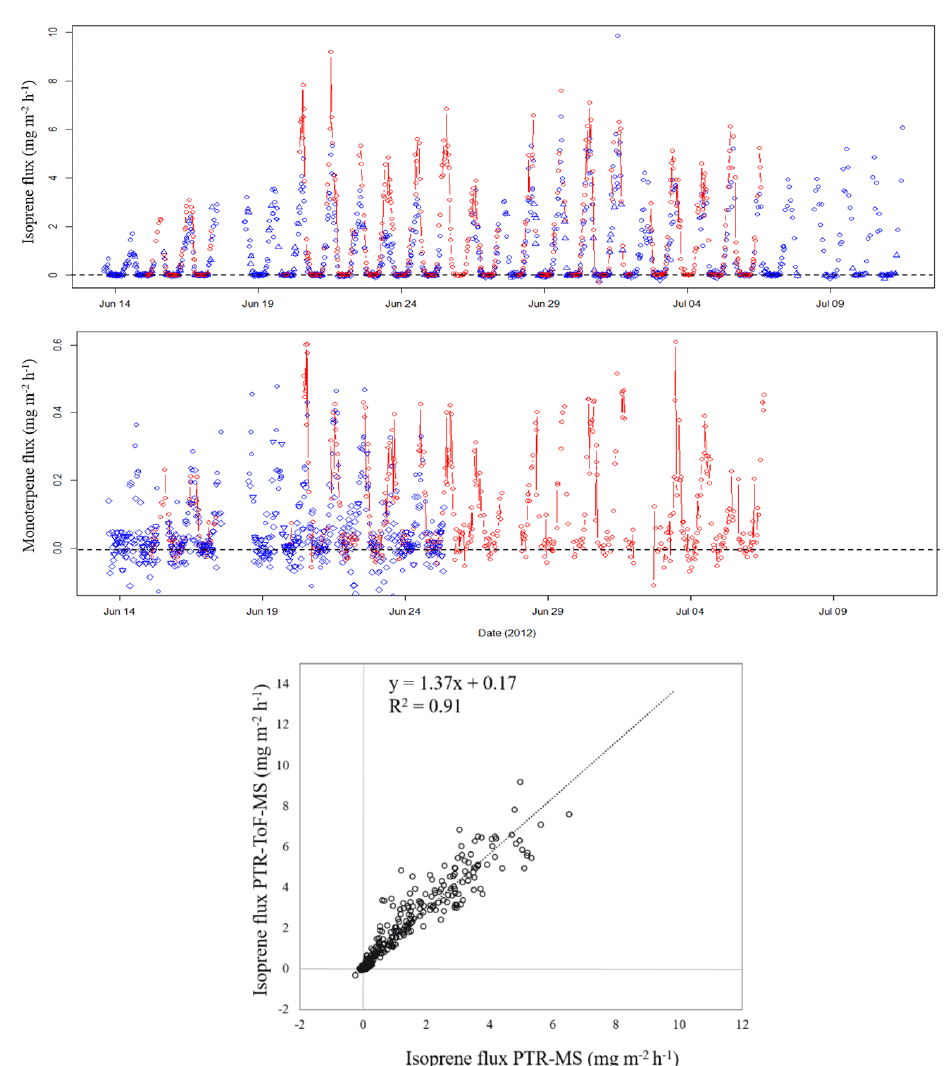
Figure 4. Time series of isoprene (top) and monoterpene (middle) fluxes (mgm − 2 h − 1 ) measured using vDEC. 25min averaged flux data from the PTR-MS which passed all tests (blue circles), fell below the u ∗ threshold (triangles) and fell below the LoD (diamonds). Red circles and lines represent PTR-ToF-MS isoprene and monoterpene fluxes with 30min averaged flux files failing the stationarity test removed. Bottom: scatter plot showing the relationship between isoprene fluxes calculated using PTR-MS and